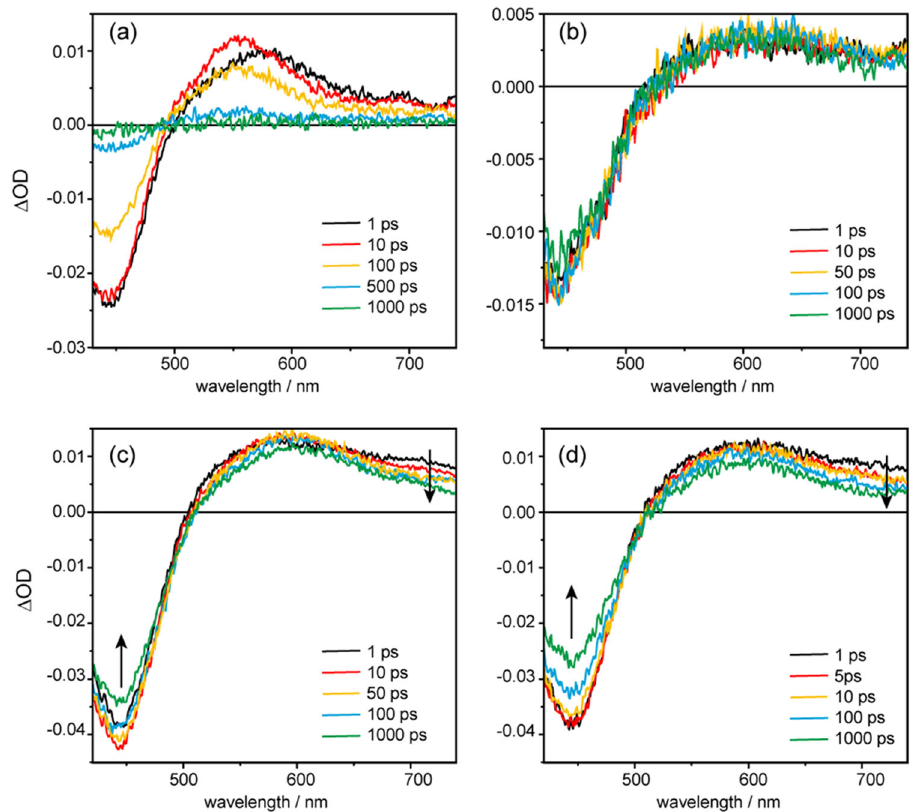
Fig. 5 The ultrafast photodynamics of [Ru(phen) 2 dppz] 2 + in G-quadruplexes monitored by femtosecond transient absorption spectroscopy. Ultrafast transient absorption spectra of [Ru(phen) 2 dppz] 2 + upon 400 nm fs laser excitation in water ( a ), ds-DNA ( b ), HT G-quadruplex ( c ), and Oxyticha nova G- quadruplex ( d ) in 10 mM Tris – HCl, and 100 mM NaCl buffer (pH 7.5). The concentrations used are [Ru(phen) 2 (dppz)] 2 + = 66 μ M, [DNA] = 132 μ M. The change of excitation wavelength to 350 nm does not change the transient absorption spectra (Supplementary Fig. 11). Though 350 and 400nm excitation may change the initial distribution of the excited states, the ultrafast depopulation results in the same 1 MLCT state and thus the same processes being